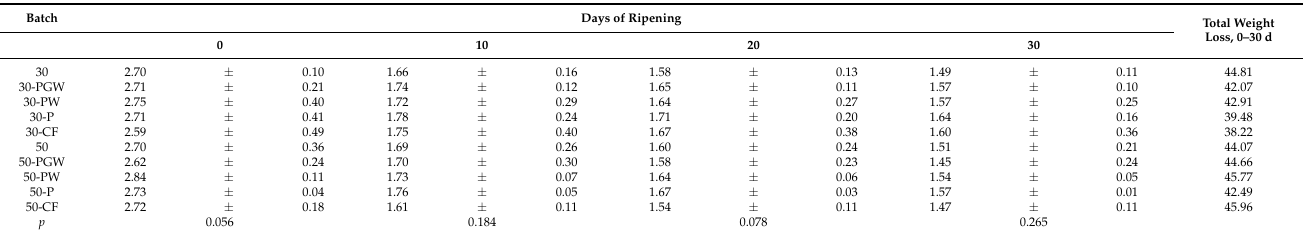
Table A1. Average values of the batch weights (kg) of sausages during drying and curing, and total weight loss (%) (mean ± SE).